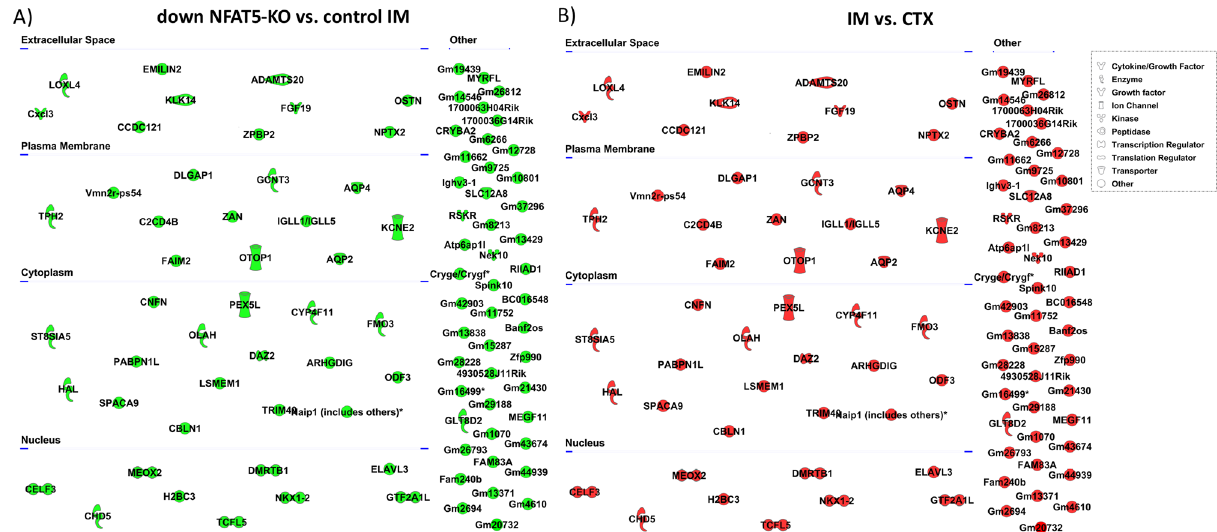
Figure 6. Top 100 decreased genes in NFAT5-KO IM. ( A ) The top 100 down regulated transcripts in NFAT5-KO IM compared to control IM. ( B ) Changes in expression level in control IM compared to control CTX. The color shows the direction of regulation (green = down regulated; red = up regulated). Color intensity indicates the relative differences in expression, with stronger staining marking a difference of a log2 fold change of − 1/1 or greater.